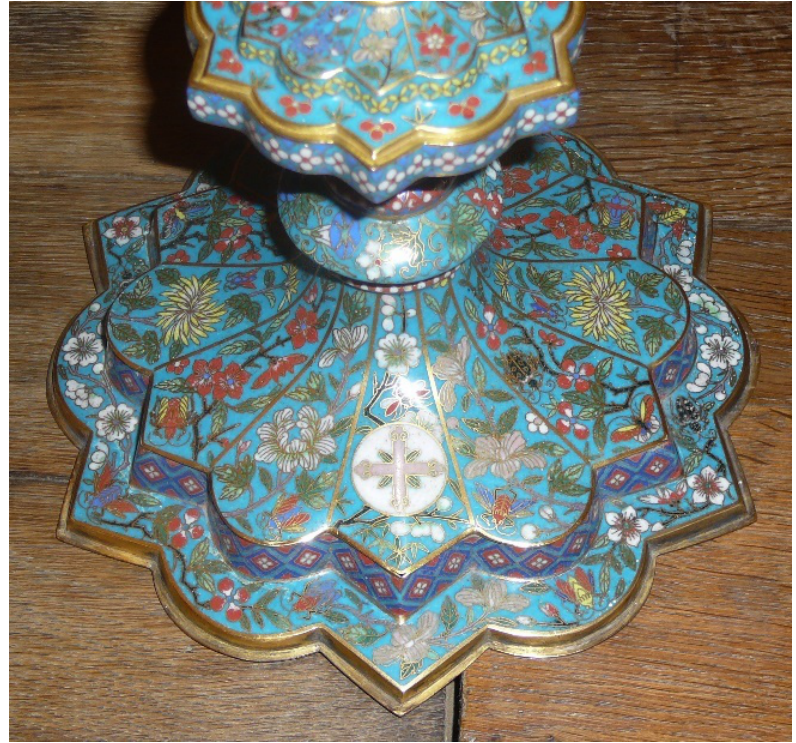
Figure 6. Chalice (detail of the upper side of the base) of Figure 3. Photo: Musée départemental d’art religieux de Sées.